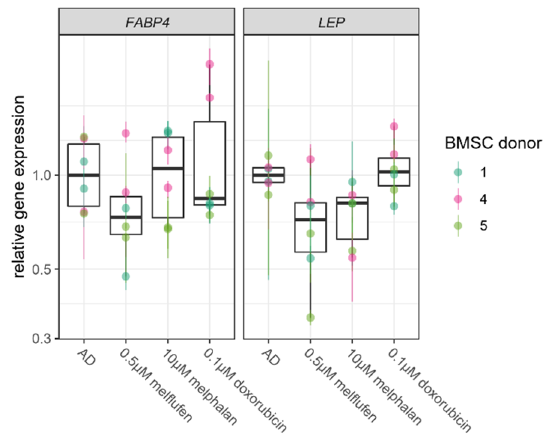
Figure 7. Drug effect on expression of adipogenic marker genes. Relative expression levels of adipogenic marker genes FABP4 and LEP in BMSCs at 21 days of culture in adipogenic differentiation conditions with 0.5 µM melflufen, 10 µM melphalan and 0.1 µM doxorubicin. Gene expression levels are shown relative to the mean expression in adipogenically differentiated control without drugs (AD). Dots represent individual culture wells with a color-coded donor cell line, and crossbars indicate the measured range.